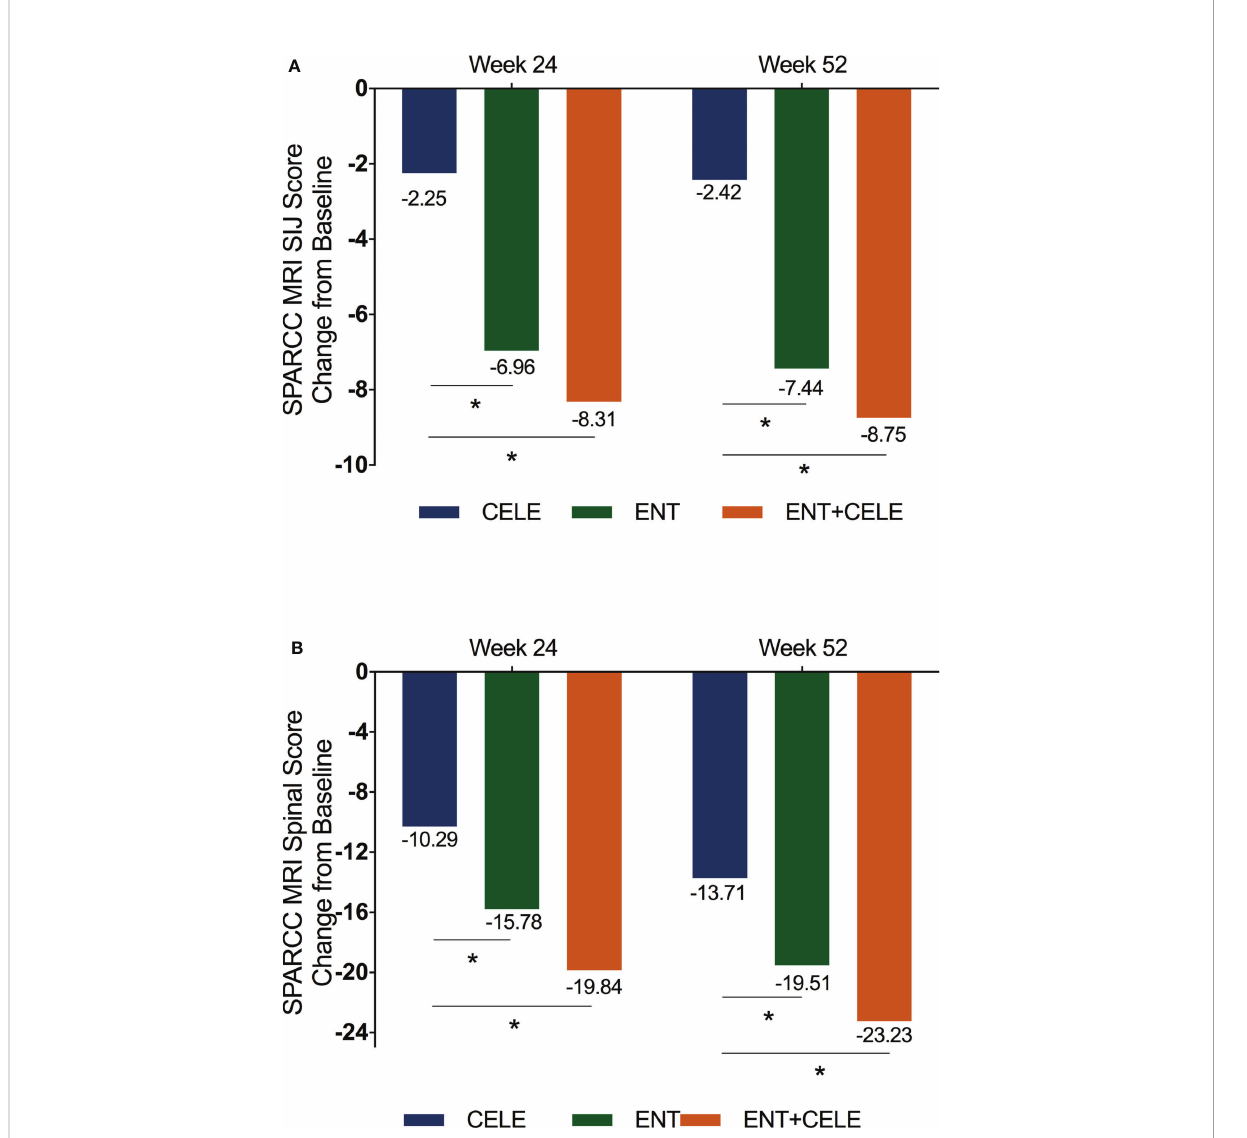
FIGURE 2 Mean change from baseline for (A) SPARCC MRI SIJ score and (B) SPARCC MRI spinal score. The mixed-effect model was used for the comparison between groups. * P < 0.05. Mean (SD) baseline values: (A) 8.63 (11.67) for CELE, 8.28 (13.65) for ENT, and 9.63 (13.08) for ENT+CELE; (B) 24.61 (14.05) for CELE, 24.14 (10.76) for ENT, and 27.80 (13.26) for ENT+CELE. Within-group P -value between baseline and week 52 from the mixed-effect model: <0.0001 for all in the SPARCC MRI SIJ and SPARCC MRI spinal scores. Within-group P -value between baseline and week 24 from the mixed-effect model: <0.0001 for all in the SPARCC MRI spinal score, <0.0001 for ENT and ENT+CELE in the SPARCC MRI SIJ score, and no signi fi cant difference for CELE in the SPARCC MRI SIJ score. ENT, etanercept; CELE, celecoxib; SIJ, sacroiliac joint; SPARCC, Spondylitis Research Consortium of